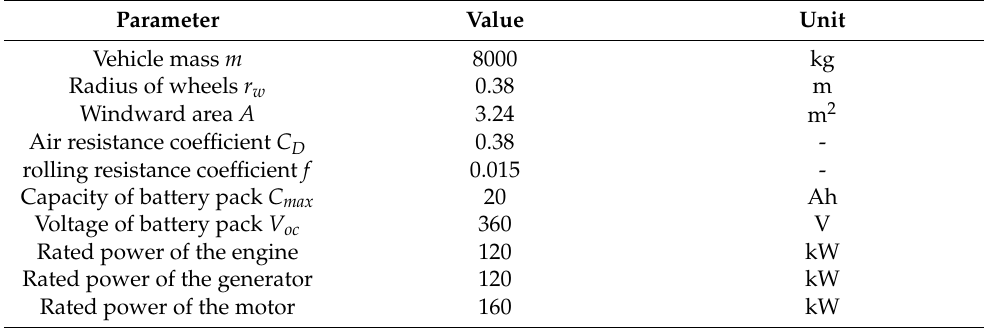
Table 4. The primary parameters of the HEV. Parameter Value Unit Vehicle mass m 8000 kg Radius of wheels r w 0.38 m Windward area A 3.24 m 2 Air resistance coefficient C D 0.38 - rolling resistance coefficient f